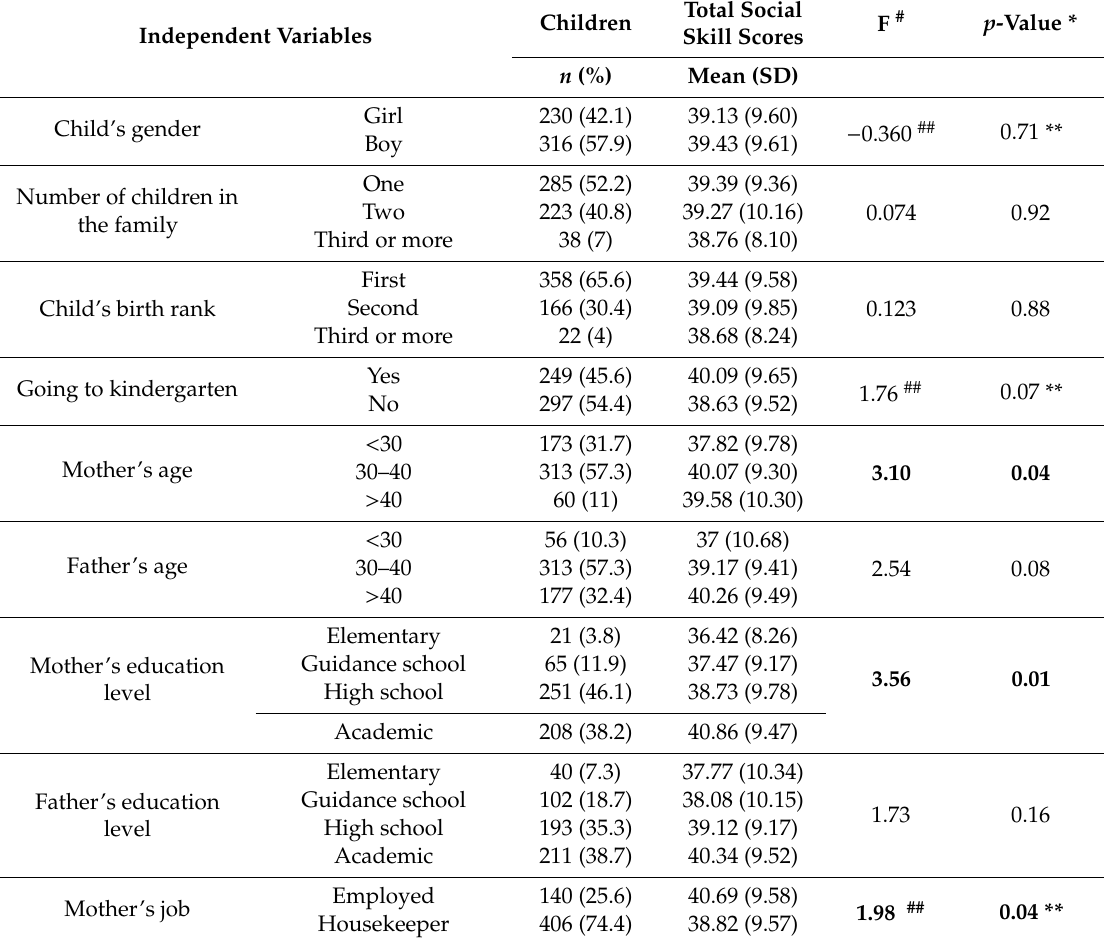
Table 1. The participants’ characteristics and their associations with the total scores of social skills of preschool children from the teachers’